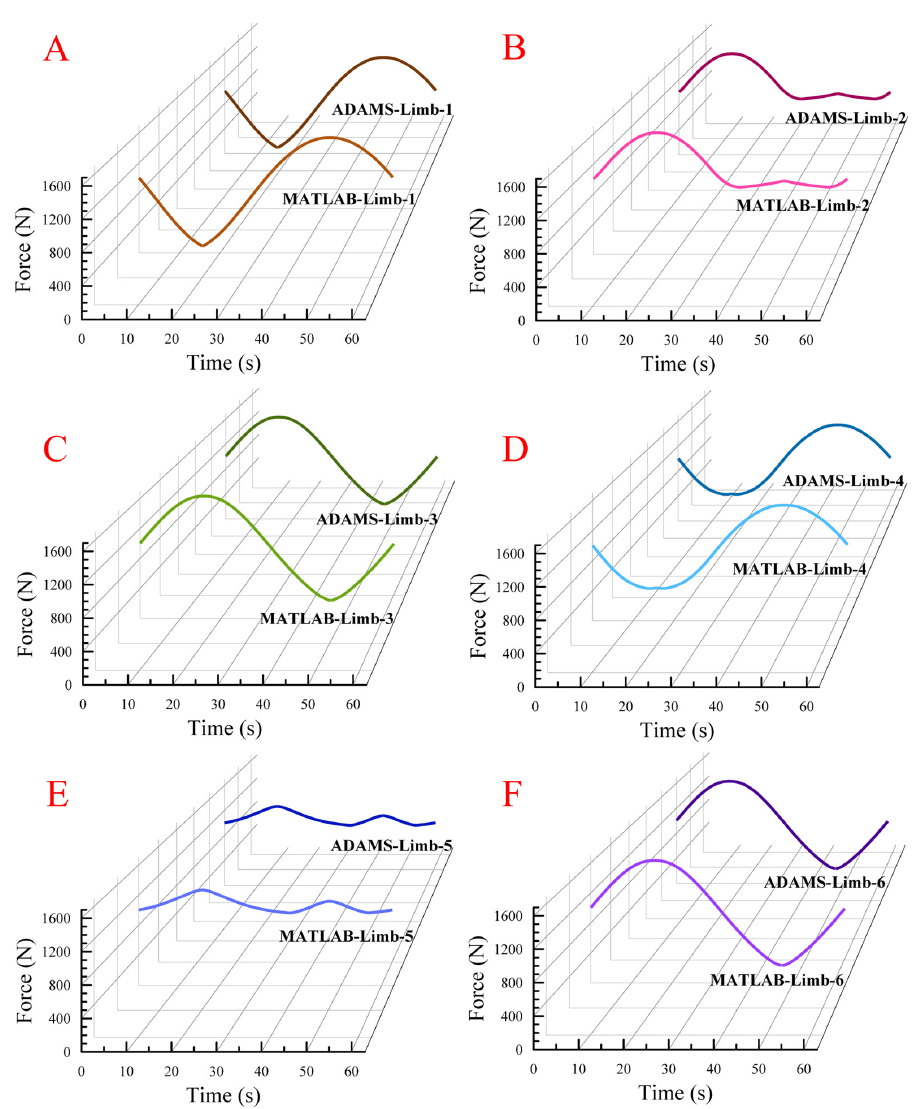
Figure 7. Simulation results of limb-driving force of the module unit 12 from MATLAB and ADAMS software:( A ) 1 th limb, ( B ) 2 th limb, ( C ) 3 th limb, ( D ) 4 th limb, ( E ) 5 th limb and ( F ) 6 th limb.